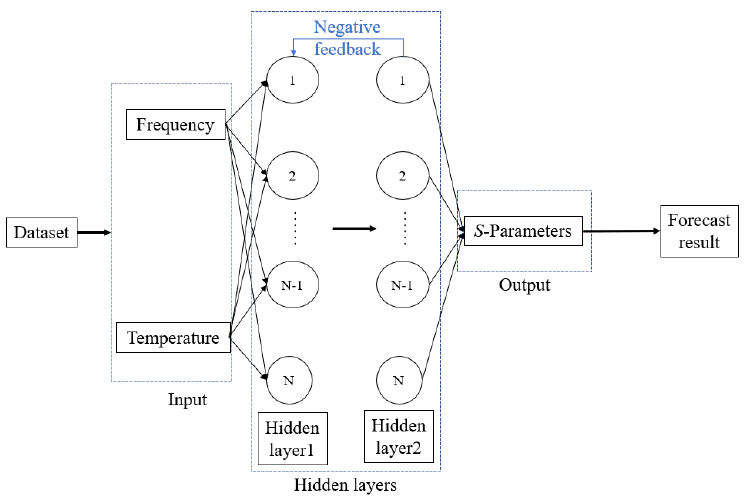
Figure 1. Schematic diagram of the structure of the BPNN.